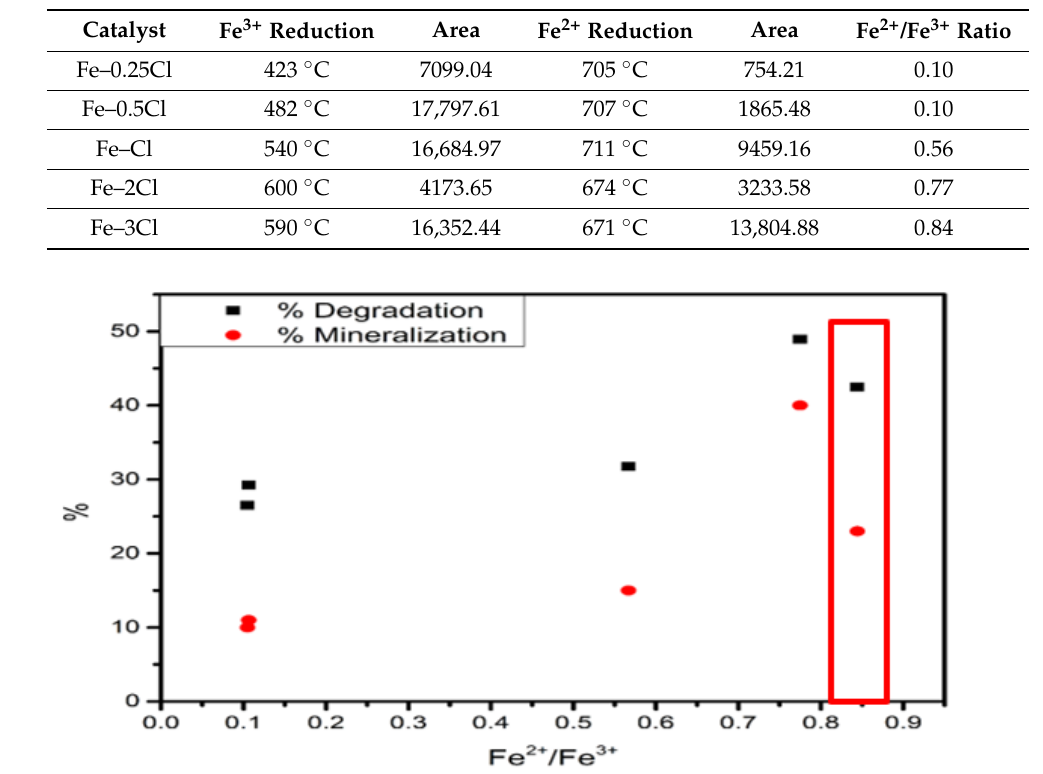
Table 9. Oxide–sulphide relation.